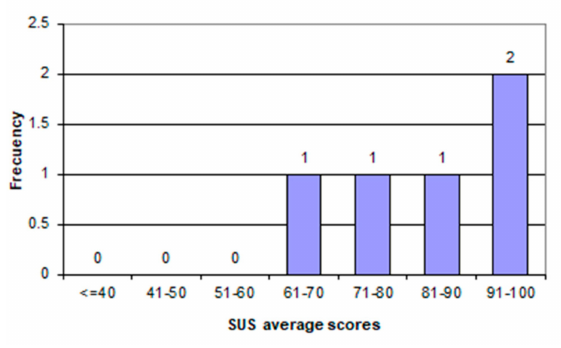
Figure 10. Average SUS